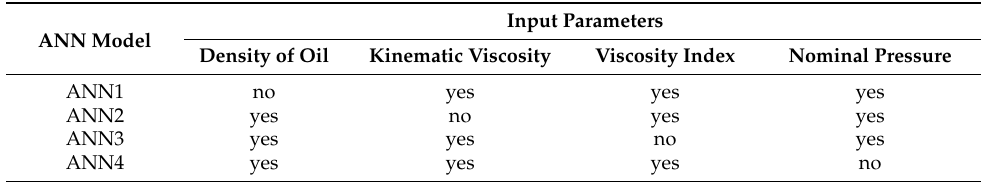
Table 3. Input parameter in artificial neural networks.